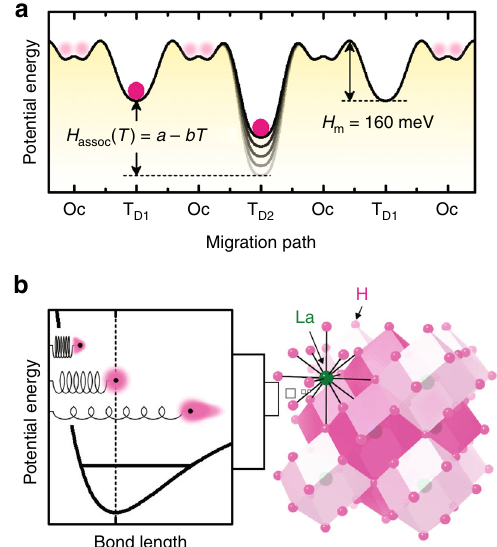
Fig. 5 Anharmonicity of H − vibration in LaH 3 − 2 x O x . a Schematic illustration of energy landscape of H − along the migration path for LaH 3-2 x O x at x = 0.25. The disordering of H − at the Oc site is also shown schematically. b Anharmonic oscillation of H − in LaH 3 . Left fi gure represents the anharmonic oscillator potential of light and highly polarizable H − , and right shows the crystal structure of LaH 3 where the rhombic dodecahedrons of LaH 14 are emphasized. The light mass and high polarizability of H − , and the framework structure composed of densely packed H − in LaH 3 − 2 x O x